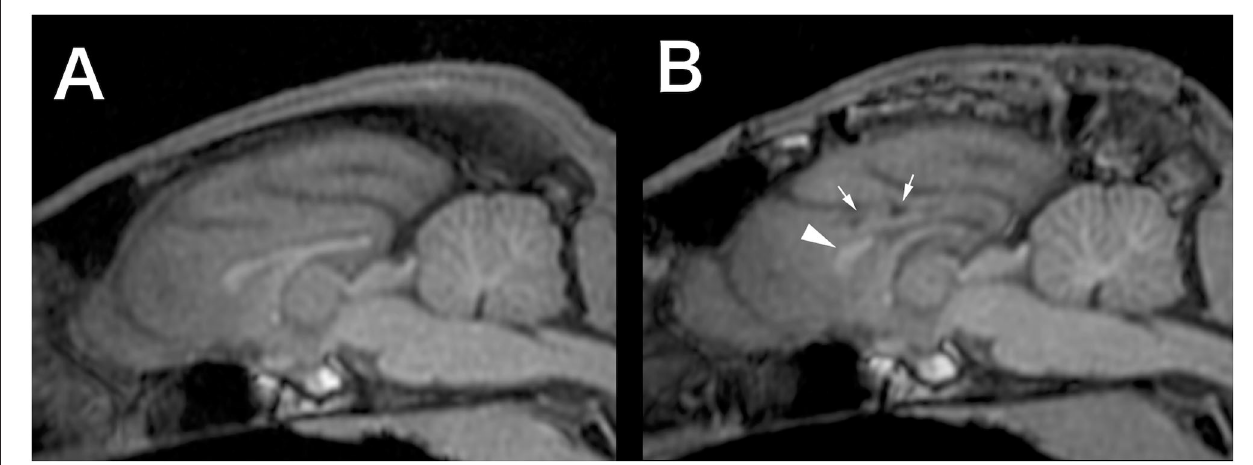
FIGURE 2 | Preoperative (A) and 12-months postoperative (B) midline sagittal T1-weighted MRI (generated by multiplanar reconstruction from 3D-T1 data). In the postoperative image, the genu of the corpus callosum (arrowhead) left intact and necrotic lesions in the cingulate gyrus (small arrows), which was damaged during the surgery, were